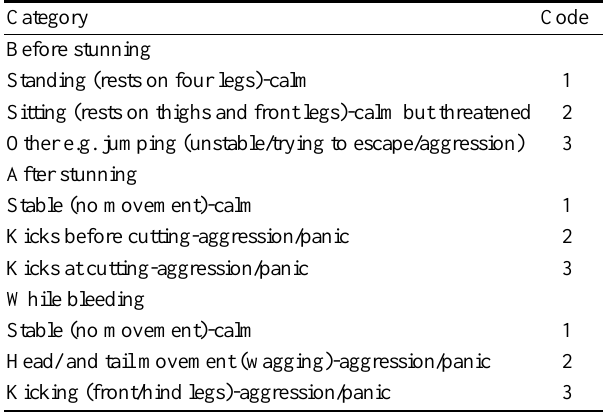
Table 1. Avoidance-related behavioural scores of sheep at slaughter